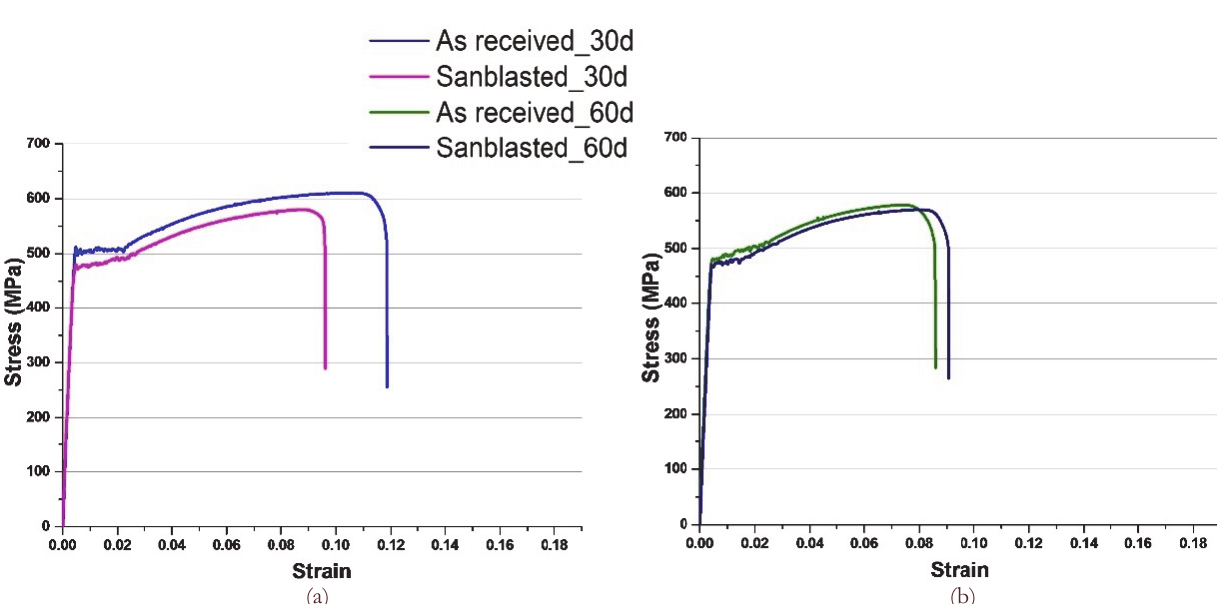
Figure 12: Tensile load-displacement curves of as-received as well as sandblasted specimen at 30 days of corrosion (a) as well as at 60 days of corrosion